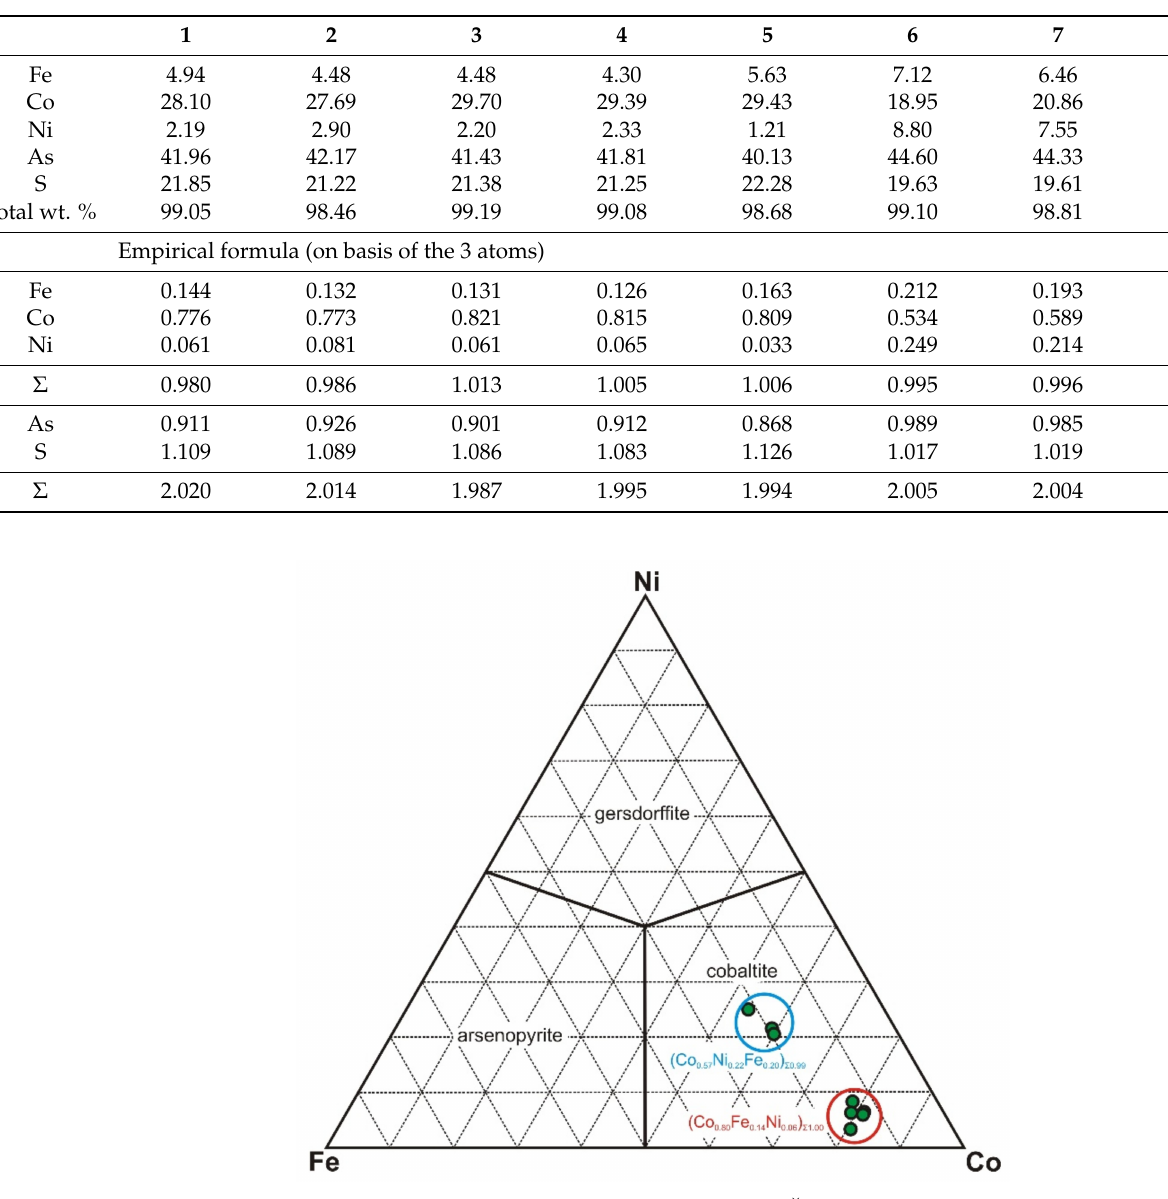
Table 6. Representative WDS microanalyses of cobaltite from ˇCuˇcma (Majersk á valley).